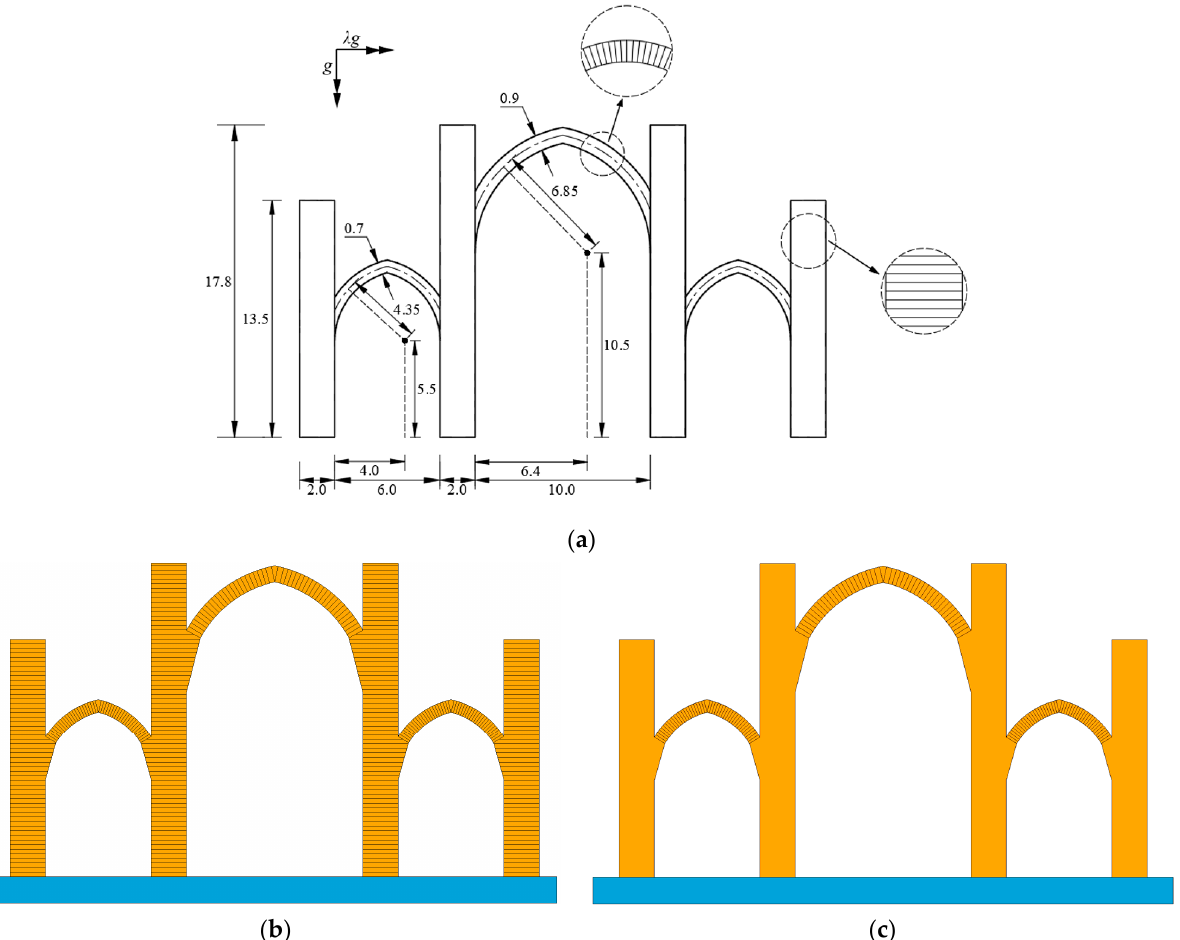
Figure 14. The multi-span pointed arch church: ( a ) geometry (unit: m); ( b ) FDEM discretisation of Scheme A; ( c ) FDEM discretisation of Scheme B.